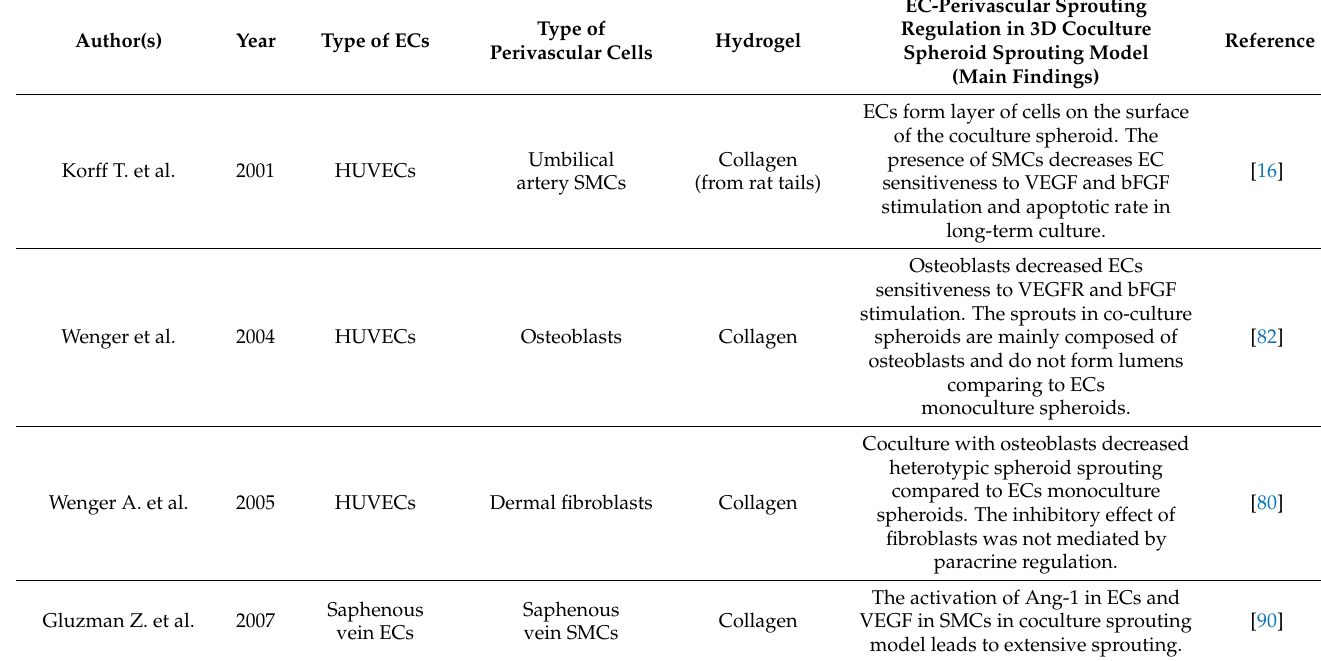
Table 1. Publications that are dedicated to the application of 3D heterotypic endothelial-perivascular cell spheroid-based assays in biomedical research. Only articles that were published in English and describing studies that focused on heterogeneous tissue spheroids containing two (or more) human cell types—endothelial and perivascular cells (pericytes, MSC, VSMC, fibroblasts, and osteoblasts)— in hydrogels were selected from the PubMed